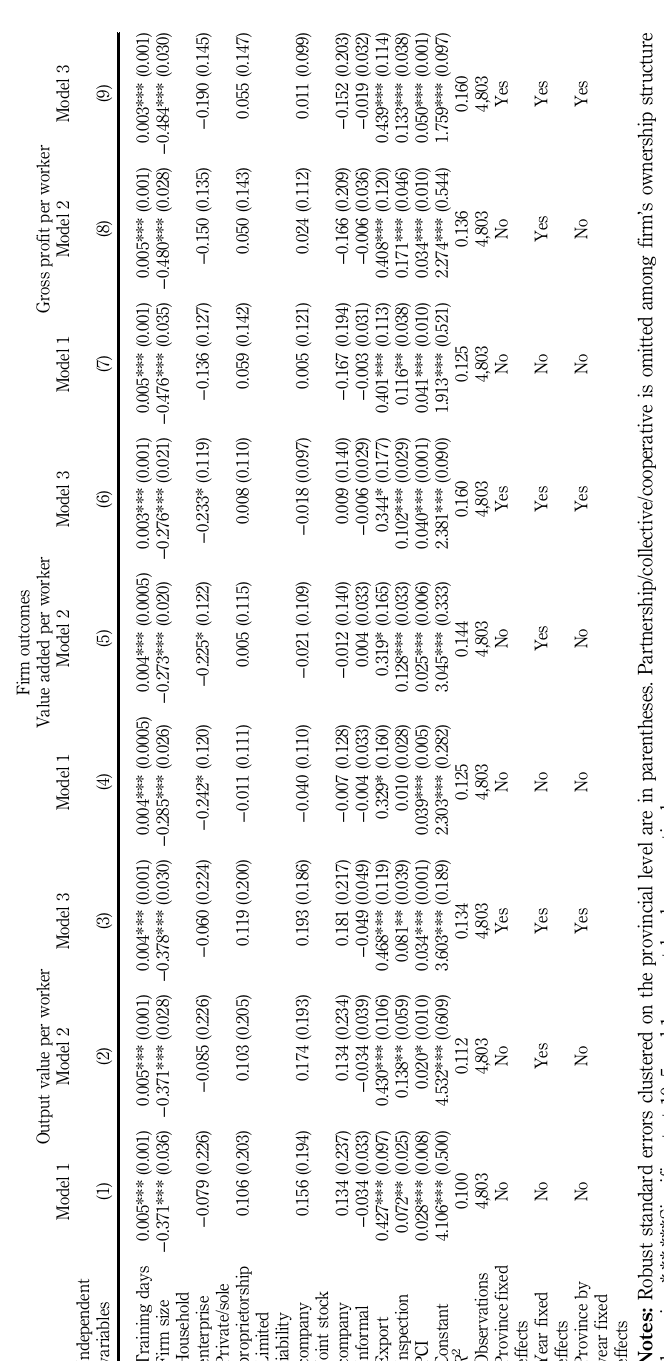
Table III. Training days and firm